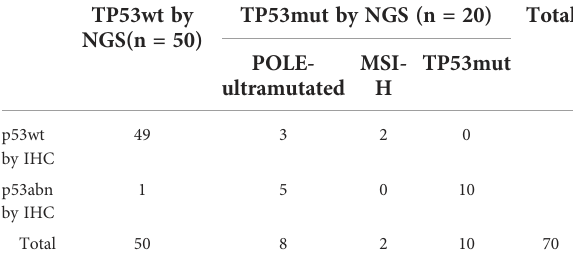
TABLE 4 Comparison of NGS and IHC for TP53 (p53) status assessment. TP53wt by NGS(n = 50)